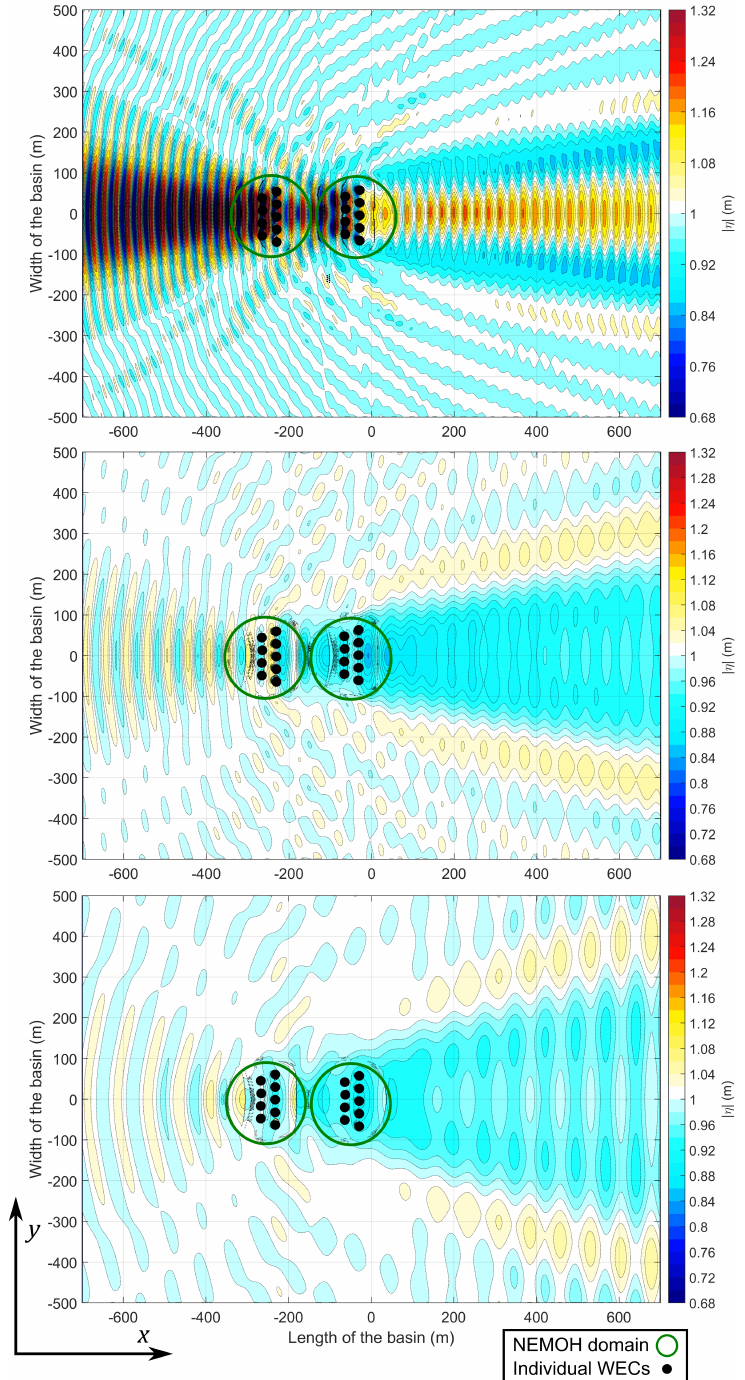
Figure 4. Wave field around two WEC arrays, I (left) and II (right), of nine heaving buoys for regular waves of H = 2 m and T = 6 s (top row), T = 8 s (centre row), and T = 10 s (bottom row). Interarray separation distance D 1 = 200 m or 2 r c . Wave incidence angle β = 0 ◦